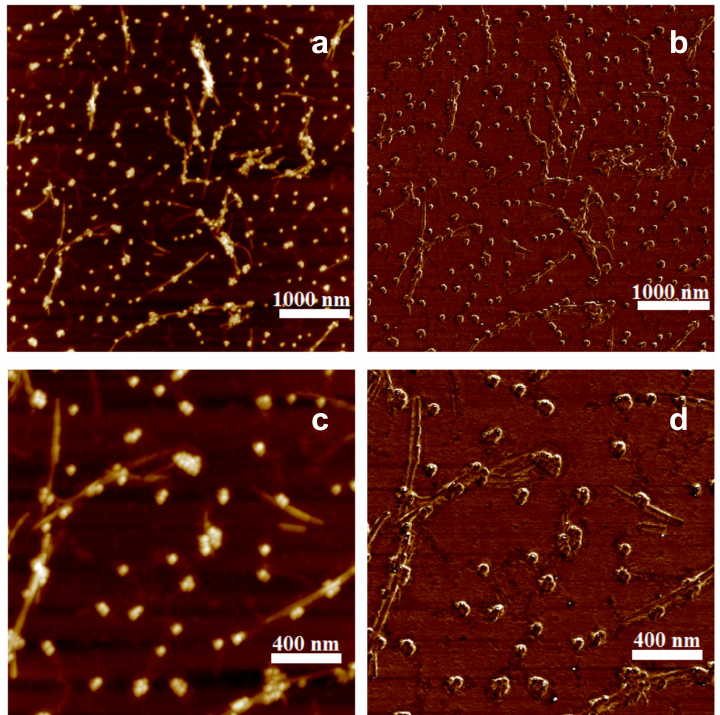
Figure 6. AFM images of LAF doped with 300 µ L of MNPs of 20 nm diameter size present topographical measurement in ( a , c ) surface height and ( b , d ) phase domain of the sample, where the lower panels are the respective magnification of the upper